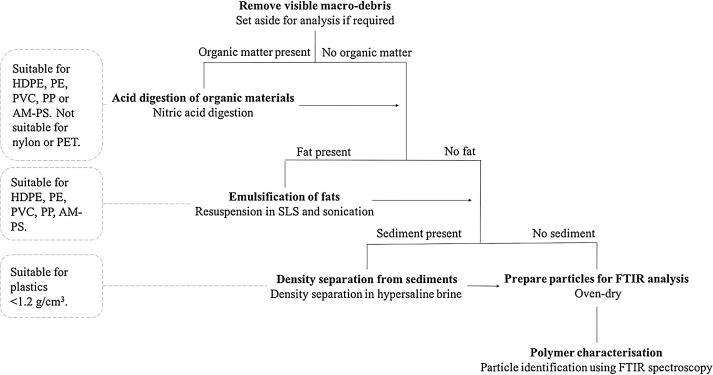
Sequential extraction protocol for the recovery of the most prevalent microplastic pollutants from green turtle chyme showing polymer suitability. List of abbreviations: sodium lauryl sulphate (SLS), polyethylene (PE), high density polyethylene (HDPE), polyvinyl chloride (PVC), polypropylene (PP), poly(ethylene terephthalate) (PET), (aminoethyl) polystyrene (AM-PS).